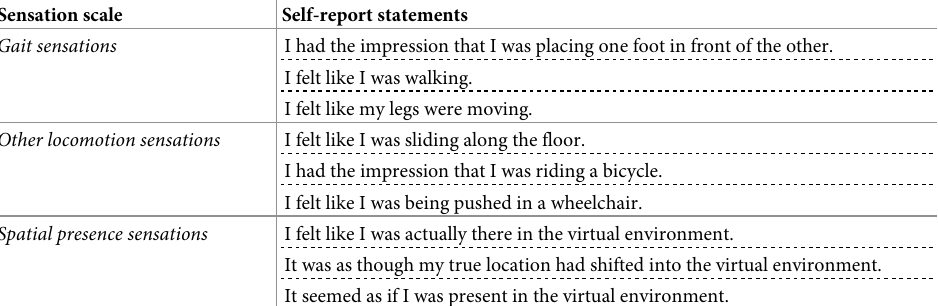
Table 1. Self-report statements used for the assessment of gait sensations, other locomotion sensations, and spa- tial presence sensations. Sensation